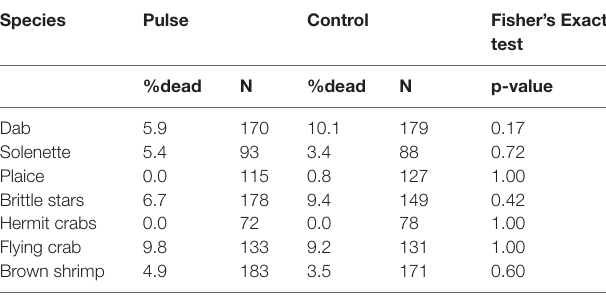
TABLE 4 | Acute mortality (% of total number of observations, N) of specimens sampled from the pulse trawl tracks (Pulse) and from the unfished control areas